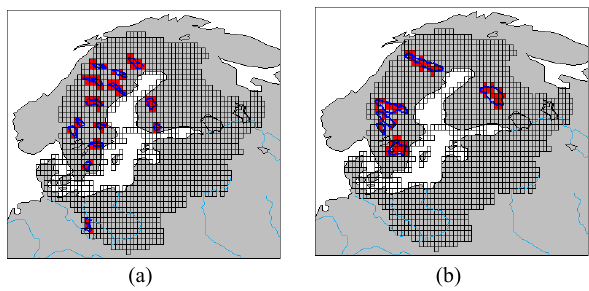
Figure 7a,b: Map of the Baltic Sea drainage basin as shown by 0.5 degree STN-30p global 4 Fig. 7. (a, b) Map of the Baltic Sea drainage basin as shown by grid cells, with two exampes of the selected source-basins and selected source-cells for the 5 0.5 degree STN-30p global grid cells, with two examples of discharge extrapolation in the Baltic Sea drainage basin. 6